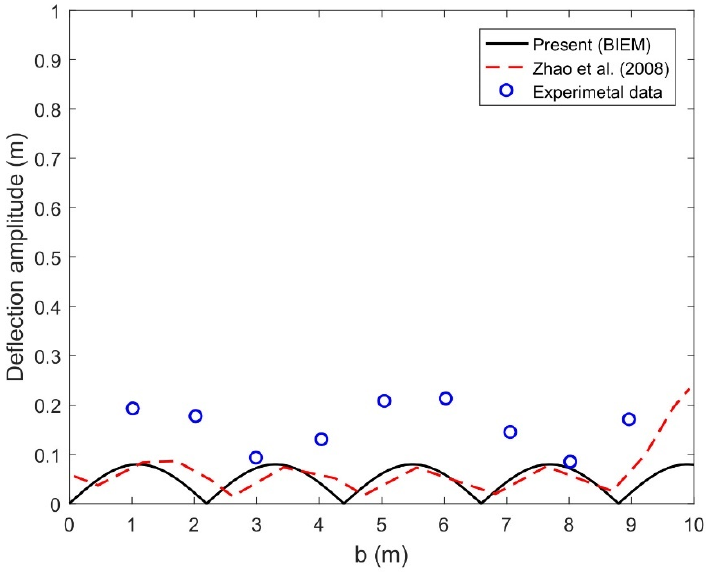
Figure 3. Comparison of the deflection amplitude with the model [24] and experimental data in [25].